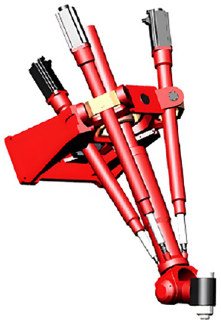
Figure 16 Tricept hybrid machining robot [56]